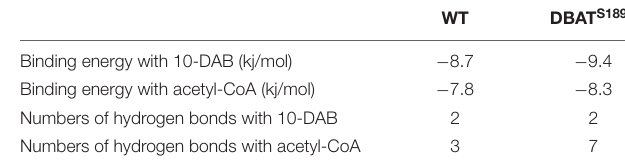
WT_10-DAB_AcCoA (WT docking with acetyl-CoA and 10- DAB), which was reflected in its improved stability ( Table 2